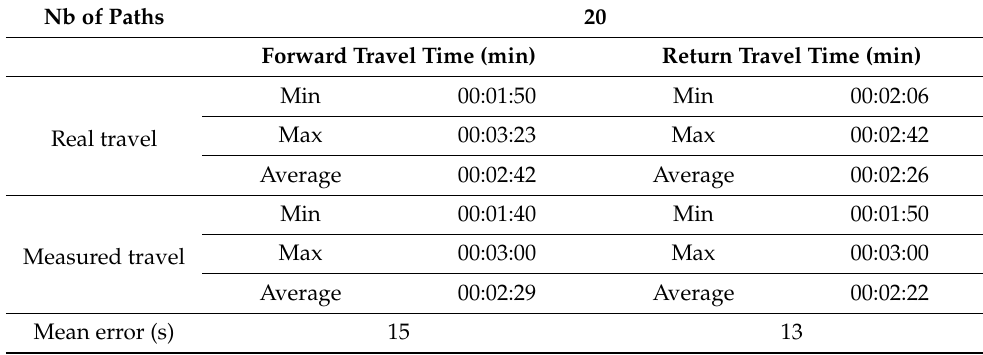
Table 5. Travel time